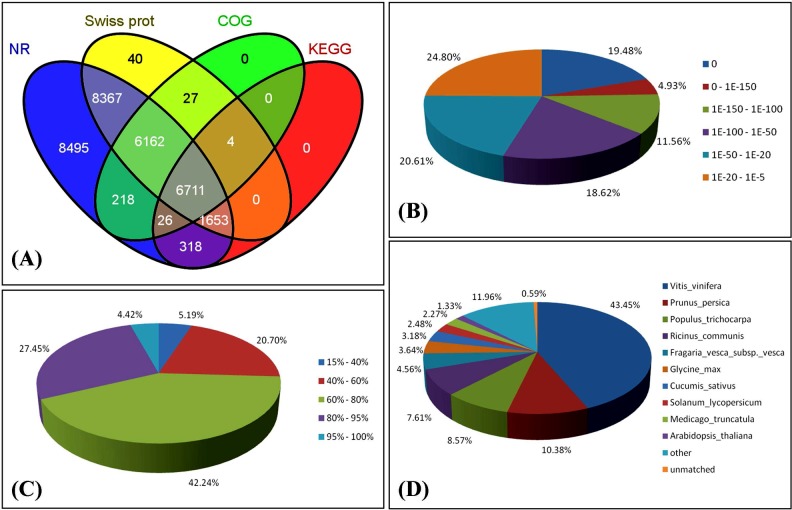
Characteristics of homology search of ‘Hangbaishao’ unigenes against the NR database.
(A) Venn diagram of number of unigenes annotated by BLASTx with an E-value threshold of 10-5 against protein databases. The numbers in the circles indicate the number of unigenes annotated by single or multiple databases. (B) E-value distribution of the top BLASTx hits for each unigene. (C) Similarity distribution of the top BLASTx hits for each unigene. (D) Species distribution of the top BLASTx hits for all homologous sequences.